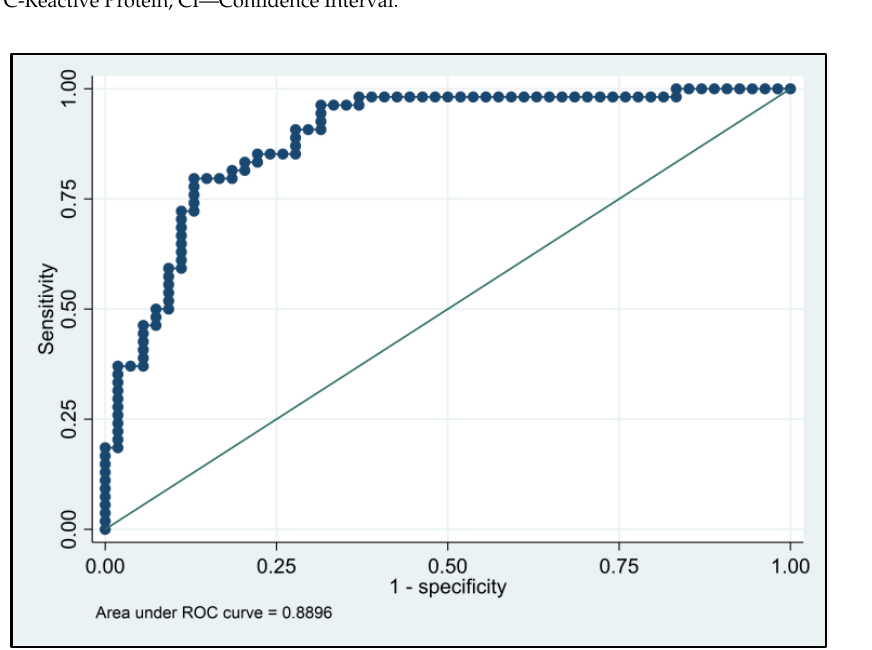
Figure 2. ROC curve analysis of CRP-NLR.